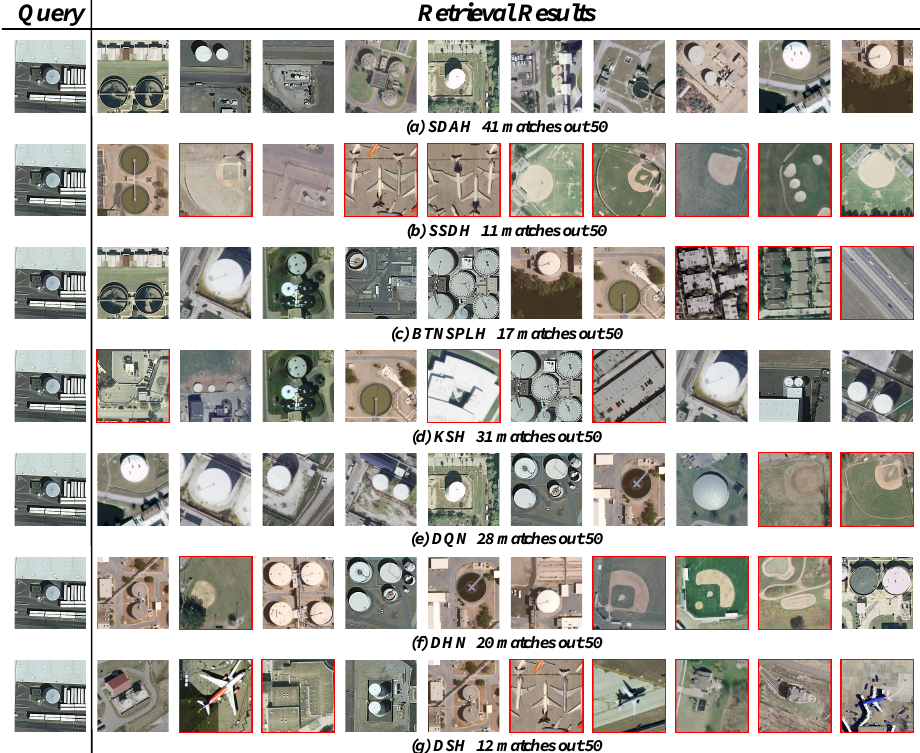
Figure 17. Retrieval examples of “Storage Tanks” within UCM dataset based on the 128 bits hash codes learned by the different hash learning methods. The first images in each row are the queries. The remaining images in each row are the Top 10 retrieval results. The incorrect results are tagged in red, and the number of correct results among Top 50 retrieval images is provided for